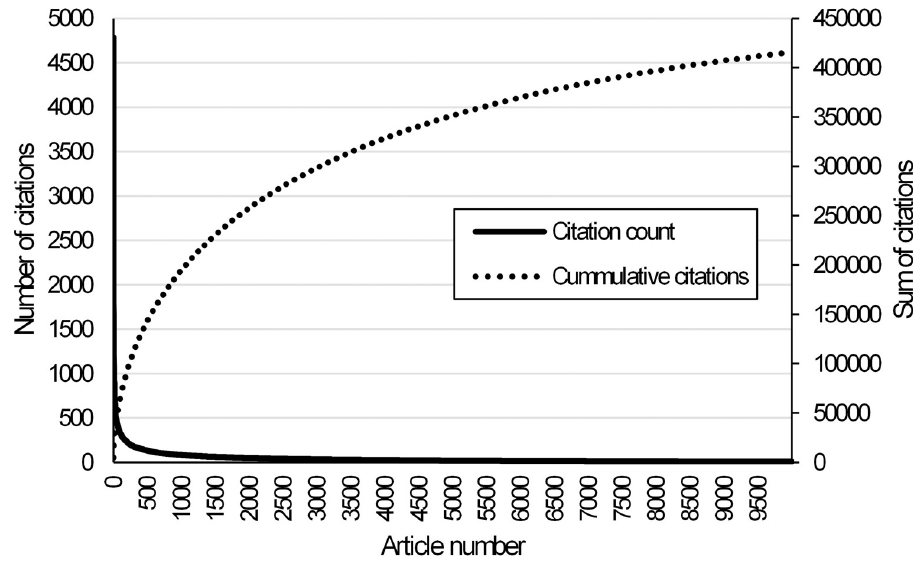
Fig 2. Articles vs. citations—Pareto